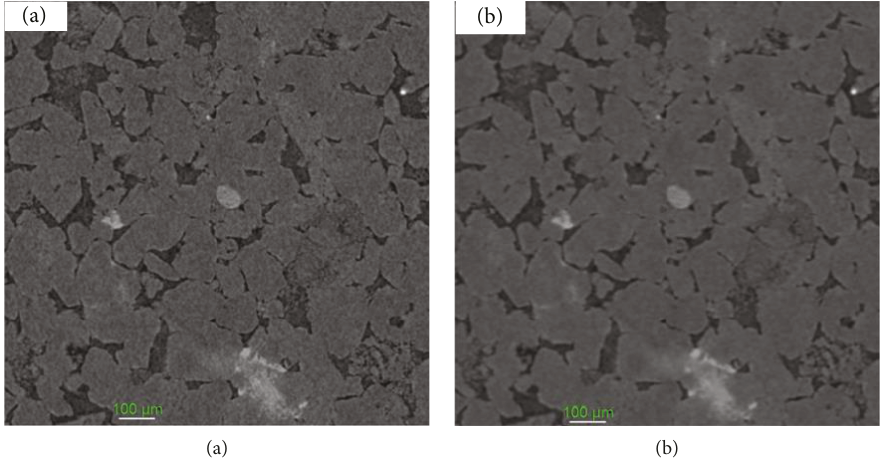
Figure 3: Images fi ltration (a) before and (b)